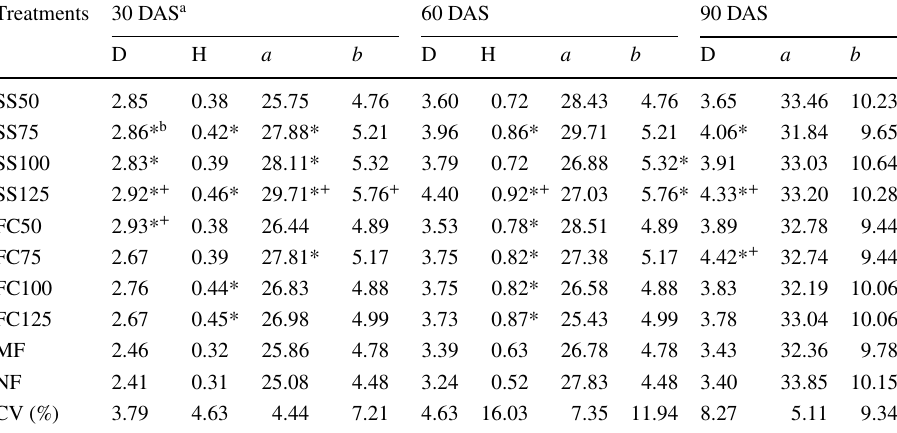
Table 5 Dunnet’s test for soybean stem diameter (D— mm), plant height (H—m) and chlorophylls ( a and b —Falker index) to compare biofertilizer treatments with the additional